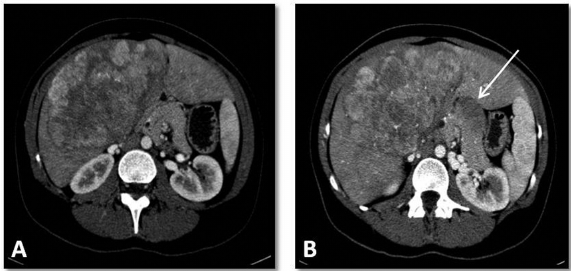
Figure 1 - Abdominal computerized tomography of a patient with fibrolamellar hepatocellular carcinoma. (A) Contrast- enhanced, arterial-phase computed tomography showing het- erogeneous enhancement of a large solid mass with small necrotic foci in segments IV and V of the liver. (B) Contrast- enhanced, arterial-phase computed tomography showing an enlarged lymph node in the hepatic portal (arrow).